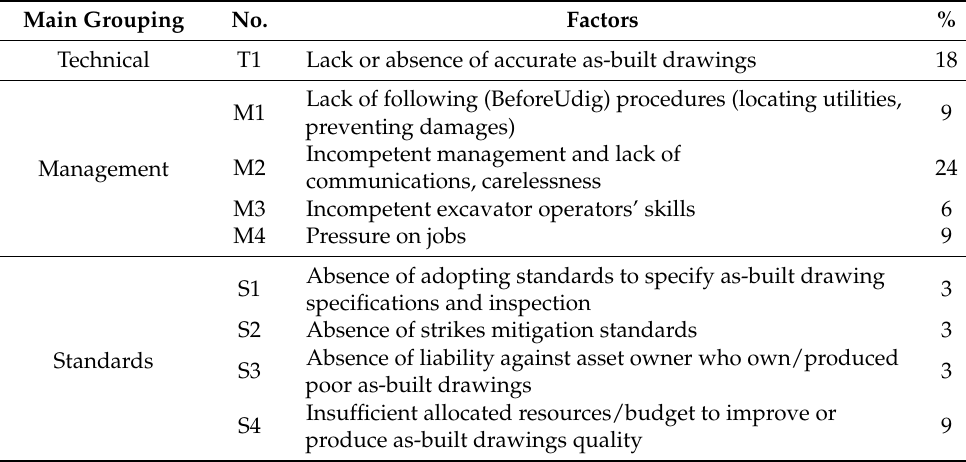
Table 3. Factors causing utility damage.